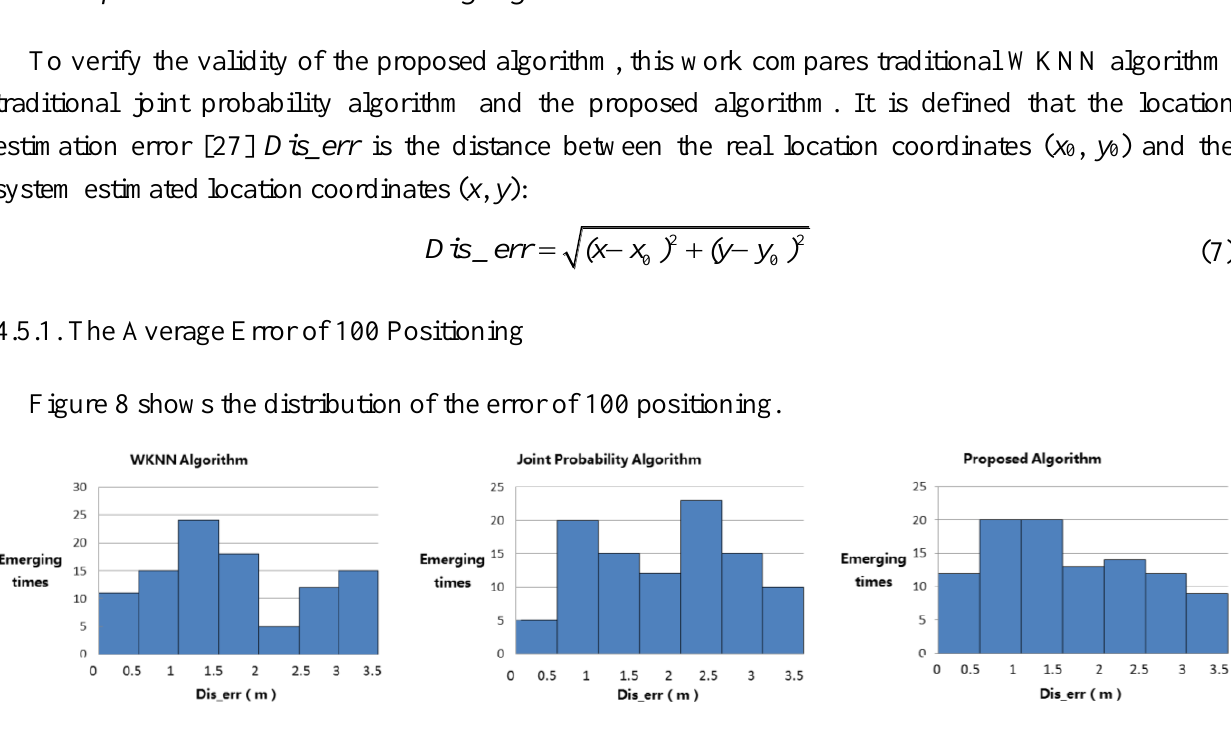
Figure 8. Distribution of the error of 100